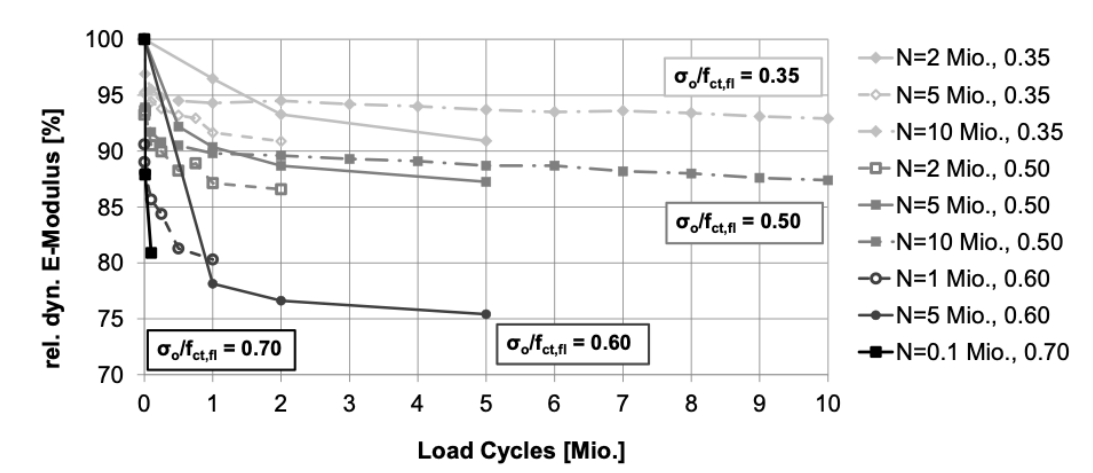
Figure 3. Decrease of the rel. dyn. E-Modulus of beams after 5 million load cycles and at di ff erent stress-ratios.